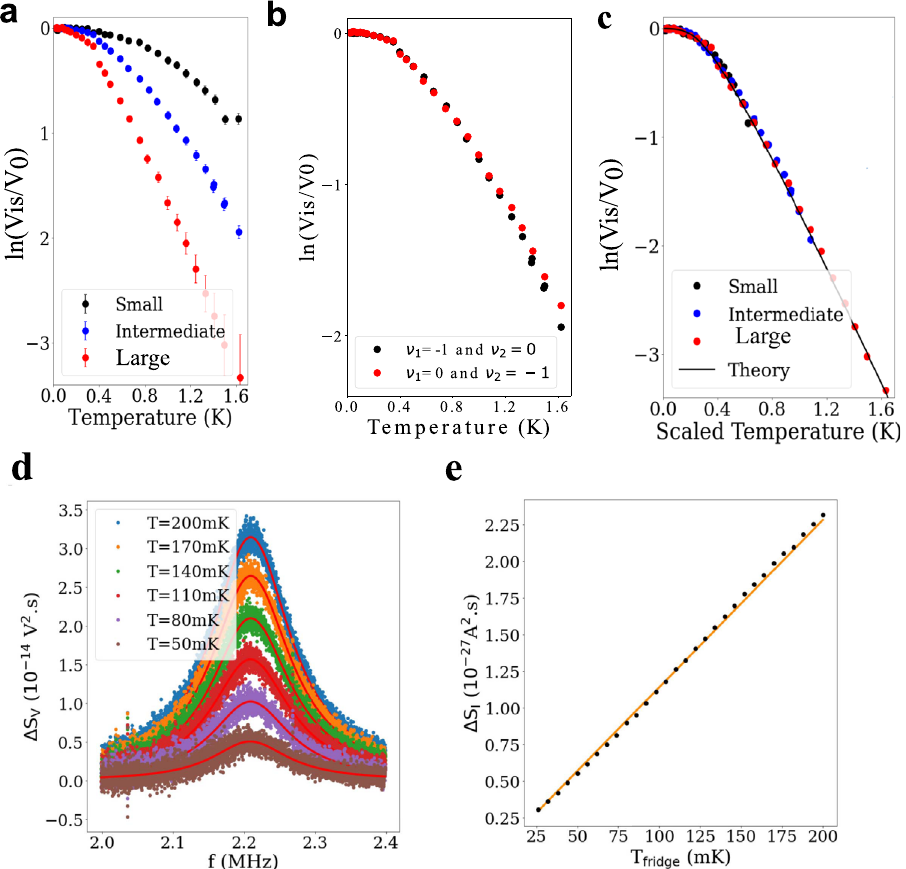
Fig. 2 | Scaling behavior of thermal decoherence. a Thermal decay of the inter- ference visibility Vis in log scale for the three interferometers. V 0 is the visibility measured at the fridge base temperature. The visibility is de fi ned as: Vis=(T MZ,max - T MZ,min )/(T MZ,max + T MZ,min )=T d /T s with T d = T MZ,max - T MZ,min and T s = T MZ,max + T MZ,min .T d andT s andtheirassociatederrors δ T d and δ T s areobtainedfromthe fi t. Visibility ’ s error bar is given by δ Vis=(T s * δ T d – T d * δ T s )/ (T s ) 2 . b Thermal decay of the interference visibility Vis in log scale for the two intermediate interferometer con fi gurations. c The decay is redrawn with scaled temperature LT / L 0 where T is temperature, L is the interferometer length, and L 0 is the length of the large